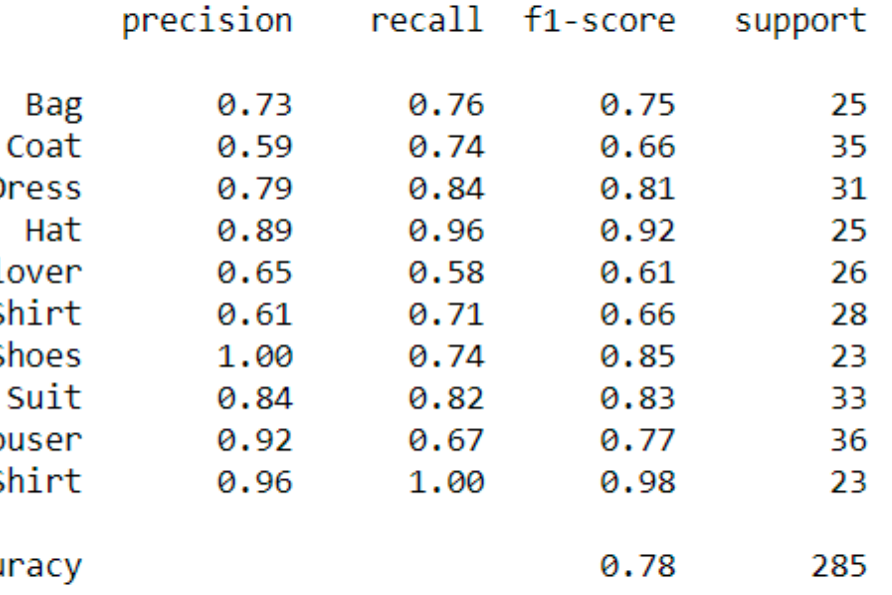
Figure 16. Classification report on the myFashion dataset.